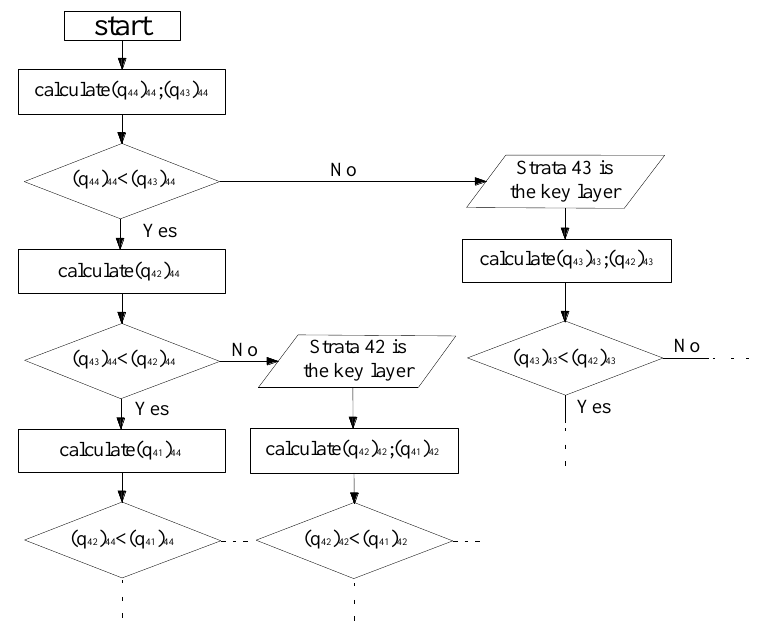
Figure 5. Key strata calculation flow.